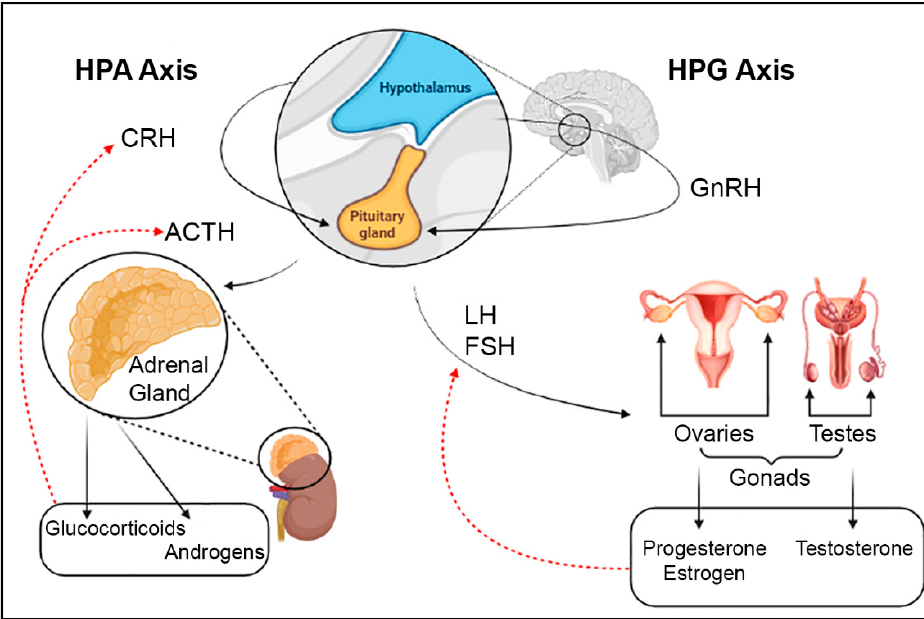
Figure 1. Outline of the pathways of HPG and HPA axes originating at the hypothalamus. Red dotted arrows represent the feedback loops that the specific components of the pathways regulate. Image created in BioRender. [ACTH: adrenocorticotropic hormone, CRH: corticotropin-releasing hormone, FSH: follicle stimulating hormone, GnRH: gonadotropin-releasing hormone, LH: luteinizing hormone].